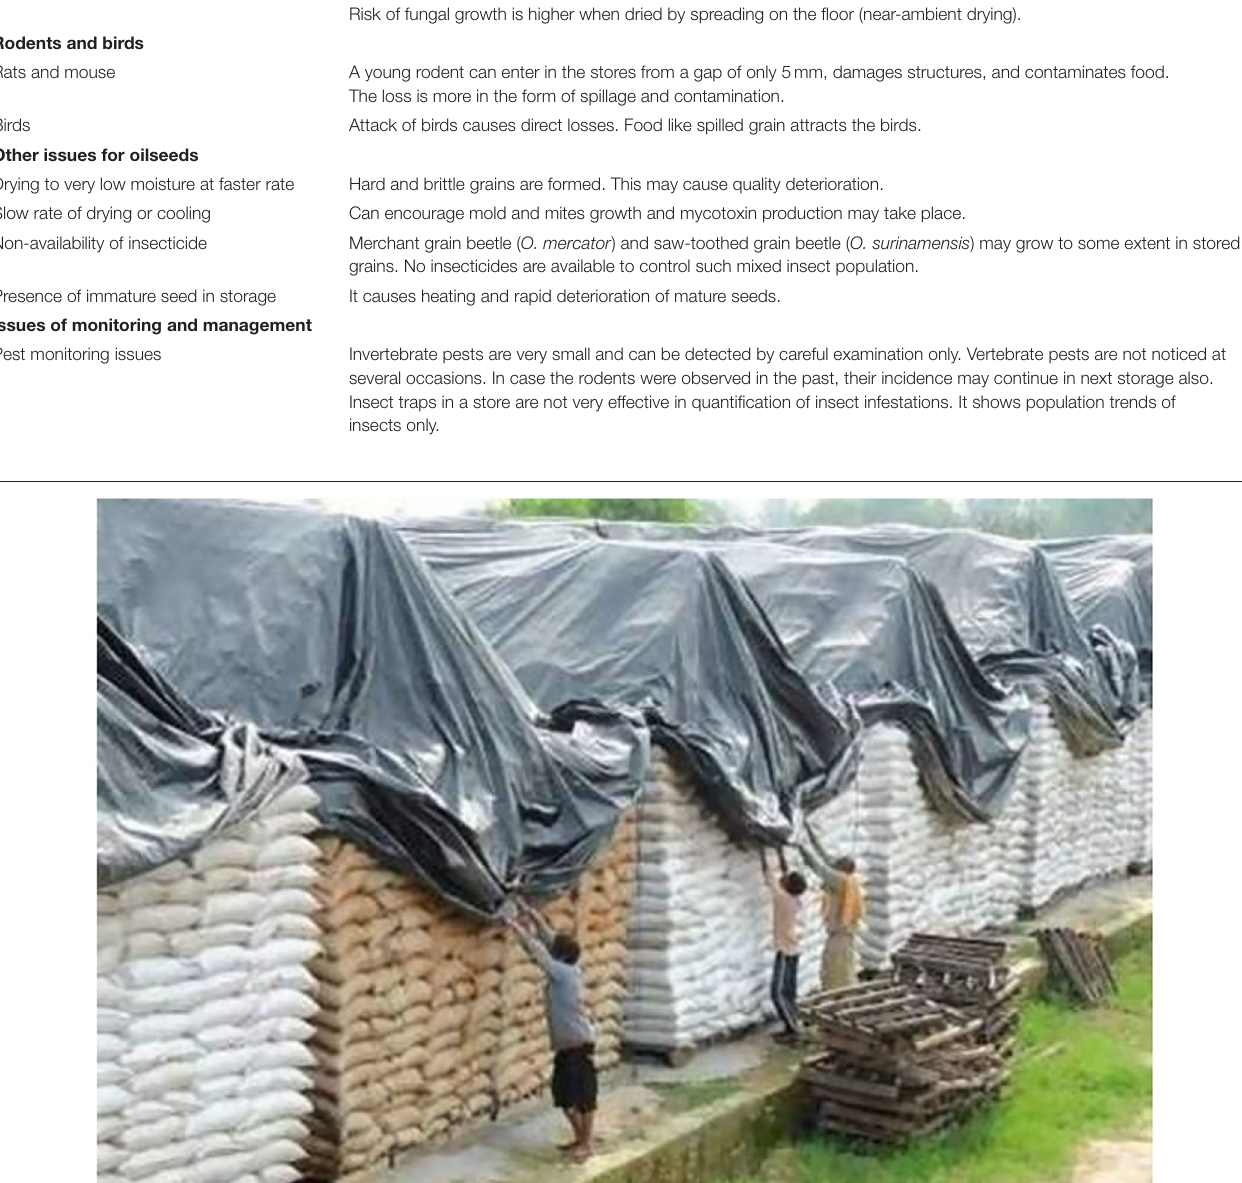
planks in which the planks are one over the other and nailed. The lower member of dunnage is of 100 × 50 mm 2 rectangular shape and 1 m long. In general, five planks at 362 mm distance from